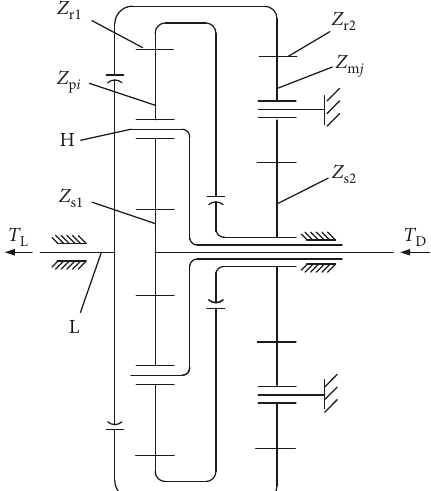
Figure 1: Schematic diagram of encased differential planetary gear